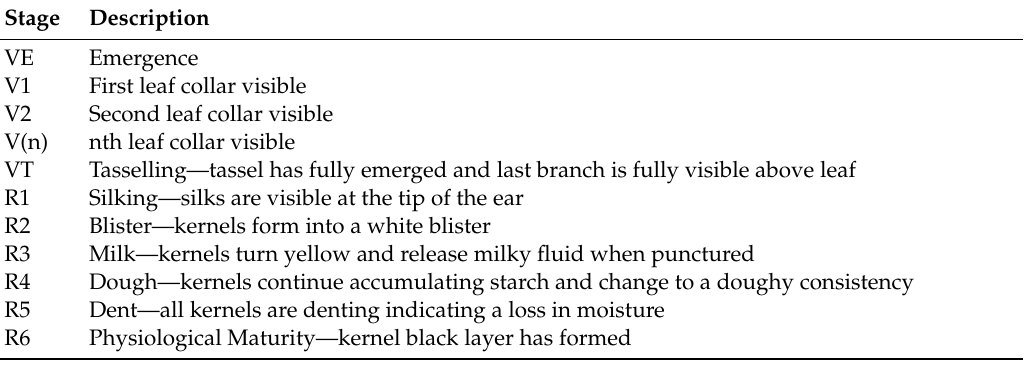
Table 2. A description of maize growth stages with commonly used